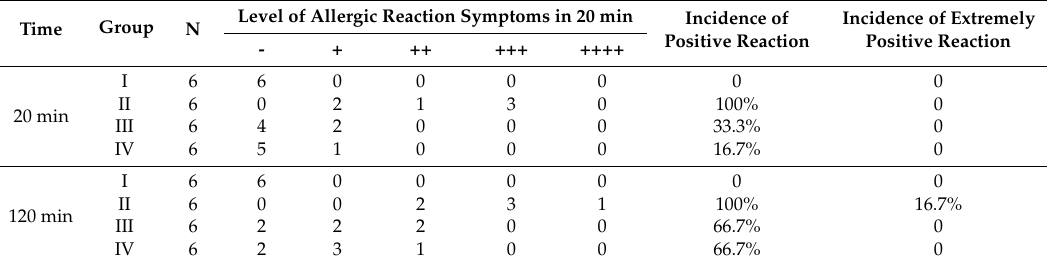
Table 2. Levels of allergic reaction symptoms of the four groups of animals at 20 and 120